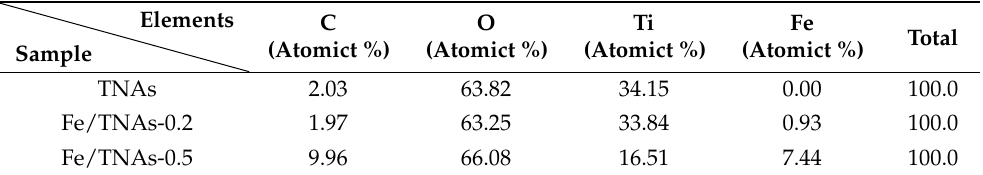
Table 1. EDX analyses for TNA, Fe/TNAs-0.2, and Fe/TNAs-0.5.